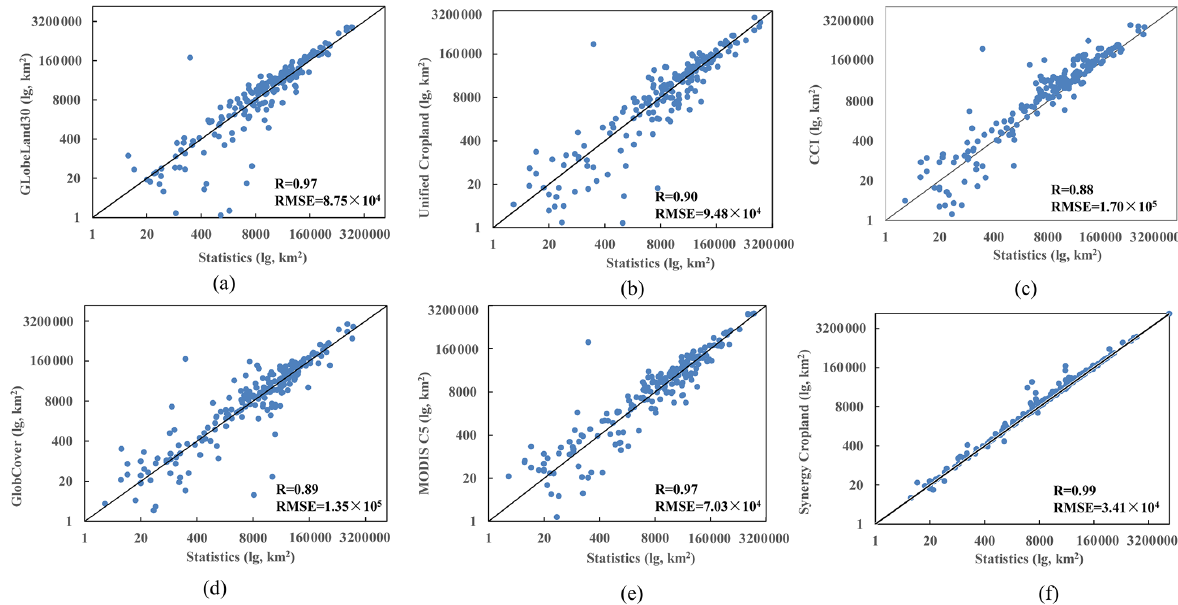
Figure 7. The consistency analysis between cropland areas estimated from products and statistics: (a) GlobeLand30, (b) Unified Cropland Layer, (c) CCI-LC, (d) GlobCover 2009, (e) MODIS C5, and (f) synergy